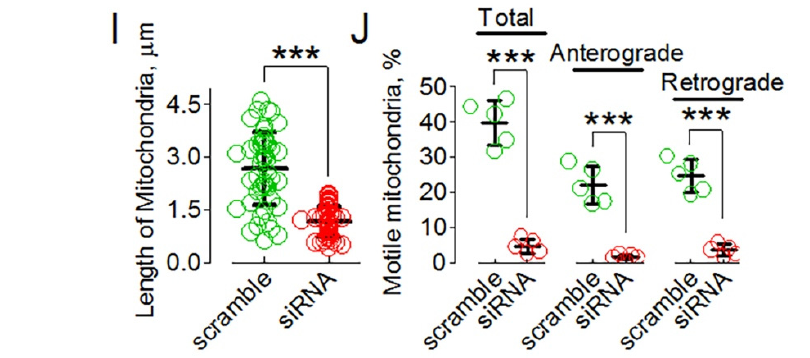
Figure 6. CRMP2 deletion with siRNA (ACTCCTTCCTCGTGTACATTT) increased mitochondrial fission and suppressed mitochondrial motility in cultured striatal neurons (10 DIV). In ( A – D ), a representative immunochemistry experiment is shown. In ( A ), bright-field image. ( B ), CRMP2 staining. ( C ), mitochondrial staining with mito-eYFP. ( D ), CRMP2 and mitochondria staining overlay. Arrows , transfected neuron. In ( E – H ), results of representative experiments with live cultured striatal neurons are shown. In ( E , F , and I ), CRMP2 deletion correlated with increased fission of mitochondria in cultured striatal neurons. Mitochondria were visualized in live neurons by mito-eYFP. Mitochondrial morphology was analyzed using 3-D reconstruction of serial images (z-stacks), which were collected as described in Materials and Methods. In ( E ), neurons were transfected with scramble siRNA; mitochondria remained normal. Transfection with anti-CRMP2 siRNA led to deletion of CRMP2 ( A – D ) and mitochondrial shortening ( F , I ), suggesting excessive mitochondrial fission. In ( I ), the length of mitochondria in μ m. In total, 100 randomly chosen mitochondria from at least 10 neurons from three different platings were analyzed. *** p < 0.001 comparing scramble with anti-CRMP2 siRNA. Data are mean ± SD. In ( G , H , and J ), CRMP2 deletion with siRNA correlated with inhibition of mitochondrial traffic in live cultured striatal neurons. In G, mitochondrial traffic in a neuron transfected with scramble siRNA. ( H ), mitochondrial traffic in a neuron transfected with anti-CRMP2 siRNA. Vertical traces show stationary mitochondria, angled traces indicate moving organelles. The strips show fluorescent images of mitochondria at the start of recordings. Mitochondrial motility was recorded for 5 min